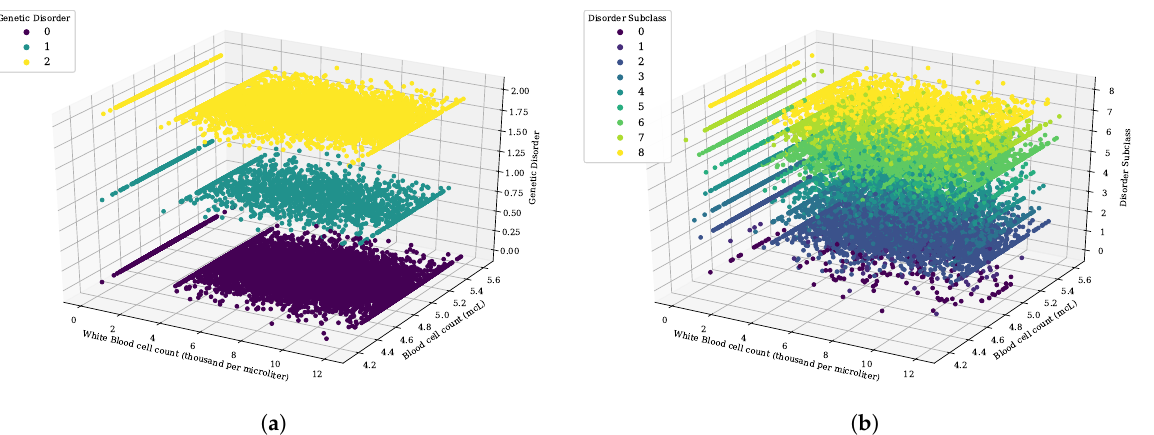
Figure 3. The 3D scatter analysis for white blood cell count (thousand per microliter) and blood cell count (mcL), ( a ) genetic disorder category, and ( b ) genetic disorder sub-category. Analysis of inherited genes that cause the genetic disorder is given in Figure 4. The analyzed genes are based on the maternal gene, paternal gene, genes from the mother’s side, and inherited from the father. This analysis demonstrates that the genes are the prominent factors that are causing the genetic disorder. Analysis reveals that when the maternal and paternal gene value is 0 or 1 the mitochondrial disorder has a higher probability while single gene disorder has less chance of happening. Similarly, Figure 4c,d demonstrate that the mitochondrial disorder has a higher chance when the values of the genes on the mother’s side and inherited from the father are 0 or 1.